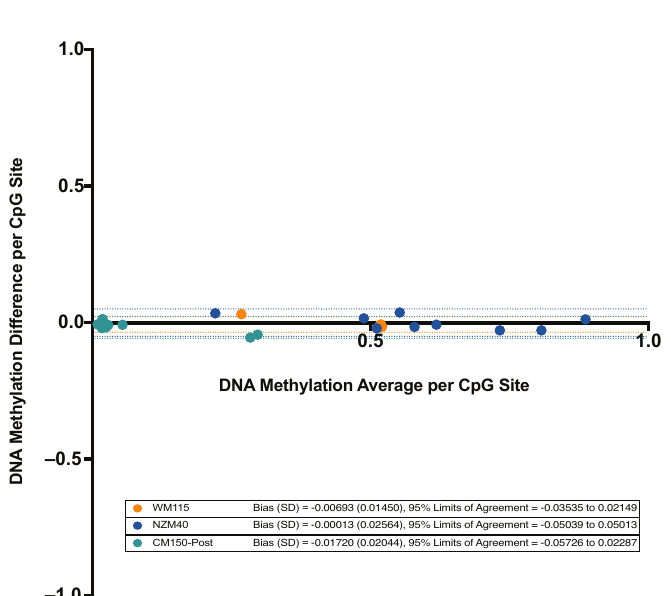
Figure 3. ( a ) Targeted DNA methylation and demethylation of the EBF3 promoter region across three human melanoma cell lines. Average levels of DNA methylation (%) ± SEM (standard error of the mean; error bars) are shown for each of the cell lines WM115, NZM40, and CM150-Post, respectively, for both unedited and methylation-edited samples (absolute values per sample as shown). Note, no error bars are shown for the NZM40 unedited sample, as the SEM is too small to represent graphically. Active demethylation is demonstrated in WM115 and NZM40, whilst active methylation is demonstrated in CM150-Post. The relative level of DNA methylation change from unedited to edited is displayed as shown (%). Corresponding heatmap representations are shown for each sample, each of which was generated using 500 randomly selected sequencing reads to illustrate the methylation status of each CpG site within the target region; methylated (red), unmethylated (blue), or unaligned (white). ( b ) Bland–Altman analysis of replicate WM115, NZM40, and CM150-Post unedited samples per CpG. Plotted results of the Bland–Altman analysis between the corresponding per CpG methylation levels of successive replicate samples. Two technical replicates of unedited samples were analyzed for each cell line as